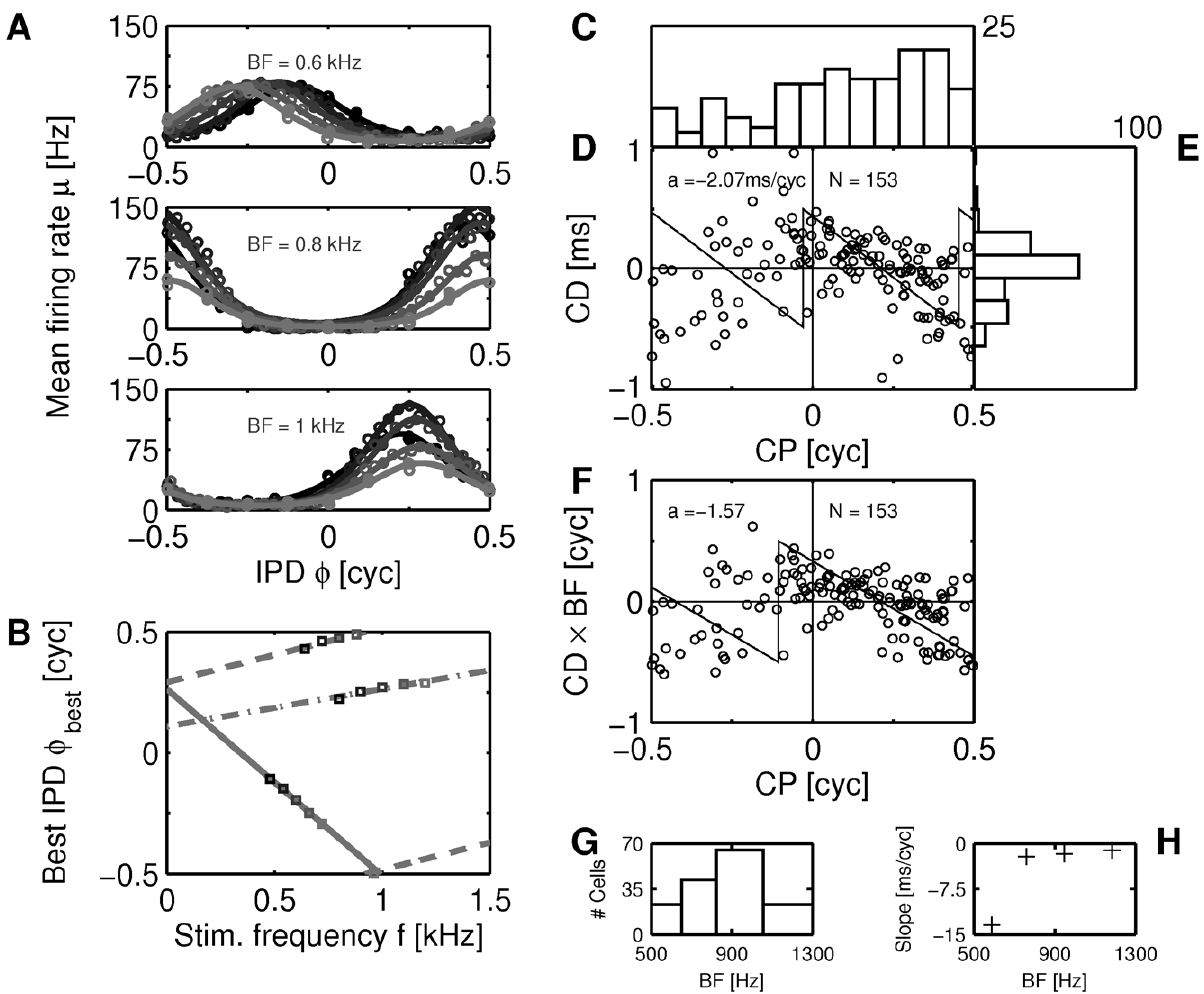
Figure 1. Frequency-dependence of ITD sensitivity. (A) Tone delay functions for three exemplary DNLL neurons using five stimulus frequencies (dark to light grey indicates low to high frequency) centered at BF. Circles depict the means of measurements, the solid lines show a cyclic Gaussian fit (see Materials and Methods). (B) Best IPD vs. stimulus frequency (phase-frequency curves) for the three neurons from A (corresponding to the three different line styles). Note that the phase axis is cyclic. (C) Distribution of characteristic phases (CPs) for 153 DNLL neurons. (D) CPs and characteristic delays (CDs) exhibit circular-linear correlation. Best circular-linear fit is depicted by the solid line ( a : slope). (E) Distribution of CDs. (F) Correlation between CP and CD | BF . (G) Histogram of BFs. (H) Average slopes a of the CP, CD | BF distribution in the four frequency bands from